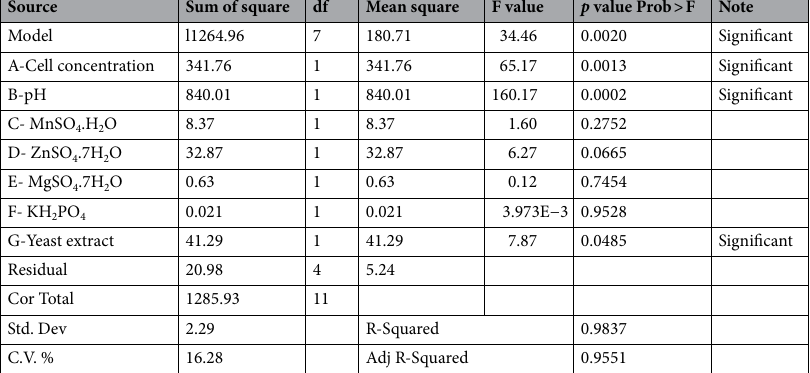
Table 5. Analysis of variance (ANOVA) from the Plackett–Burman design of ethanol production from PWH using S. cerevisiae HG1.1.